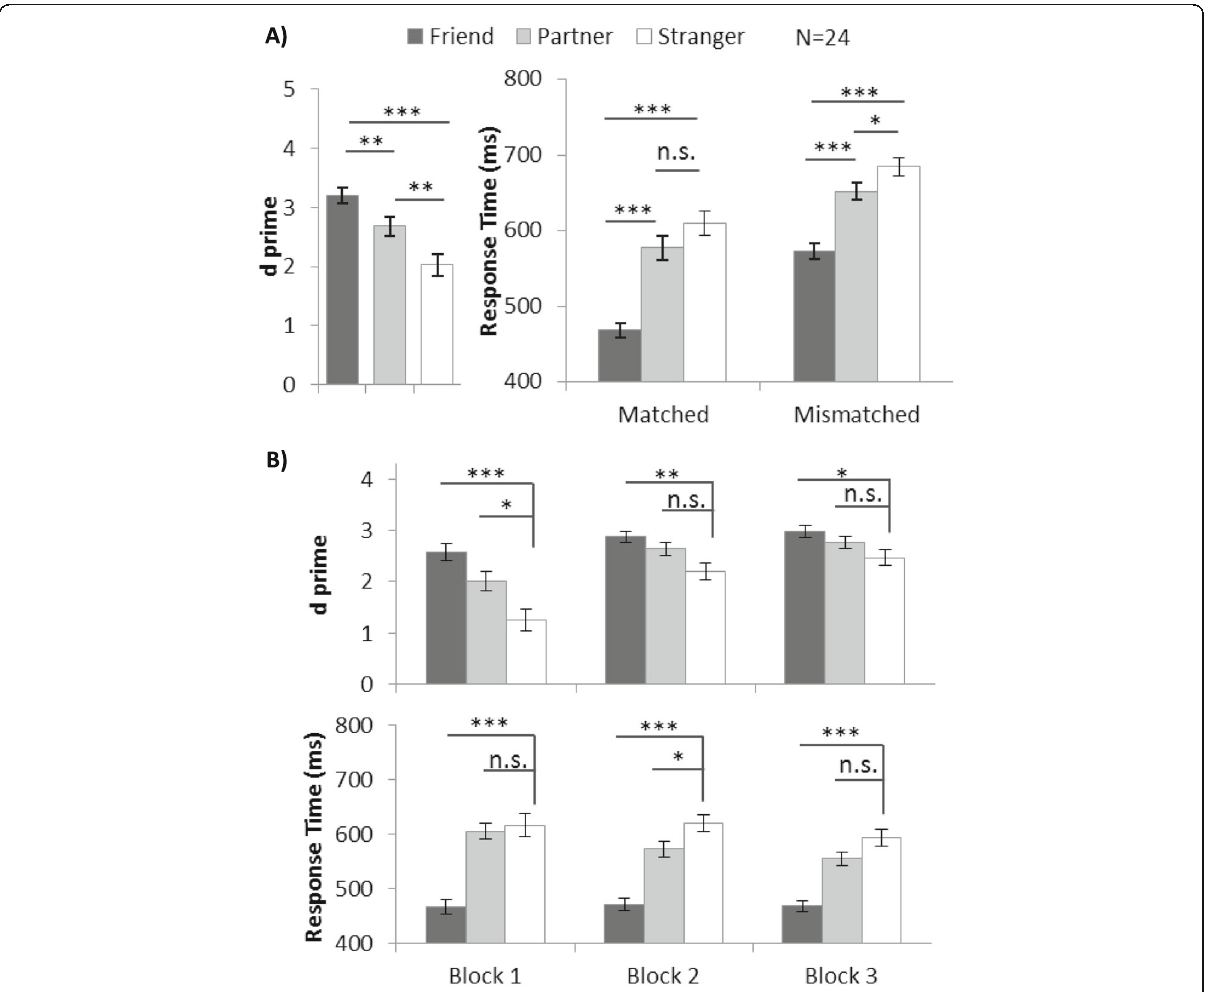
Fig. 6 a Mean and SE of d prime ( d ’ ) for different shape categories in experiment 5. b Mean and SE of d ’ and response time (RT) (matched trials) for different shape categories for each block in experiment 5 (* p < .05; ** p < .01, *** p < .001). All participants ’ d ’ values can be found in